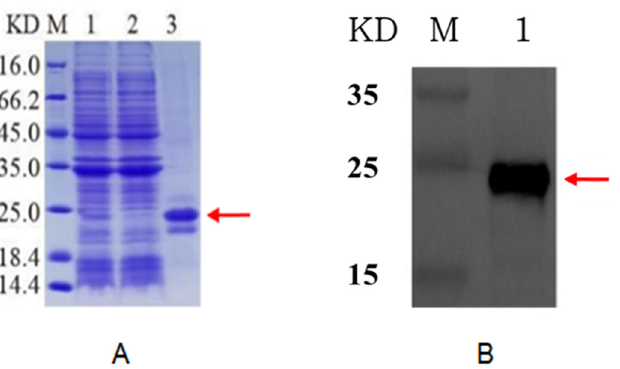
Figure 4. SDS-PAGE analysis of cut-off purified ApEGF with pET-22b expression vector encoding a 6 x His tag. ( A ): M, marker; 1, broken precipitation; 2, effluent; 3, purified protein. ( B ): Western blot analysis of purified cut-off ApEGF with anti-His tag. Lane M: marker; lane 1: purified protein. Red arrow indicates target protein.